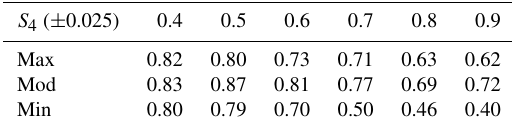
Table 3. Average value of decorrelation time E [ τ 0 ] (in seconds) as a function of the S 4 scintillation index for the periods of maximum (Max), moderate (Mod), and minimum (Min) solar activity